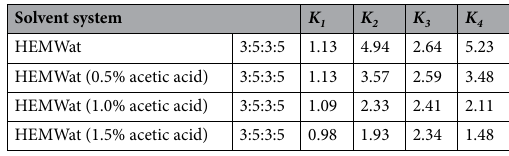
Table 1. The K values of the target